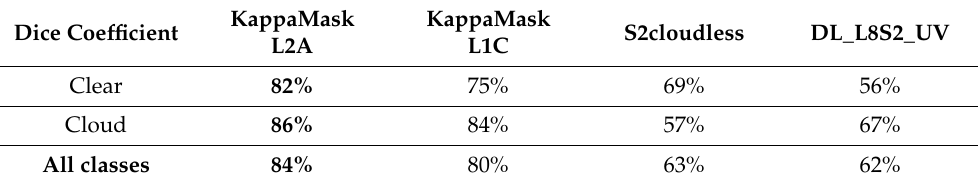
Table 6. Dice coefficient evaluation performed on the test dataset for KappaMask Level-2A, Kappa- Mask Level-1C, S2cloudless and DL_L8S2_UV cloud classification maps. Evaluation is performed for clear, cloud shadow, semi-transparent and cloud classes.